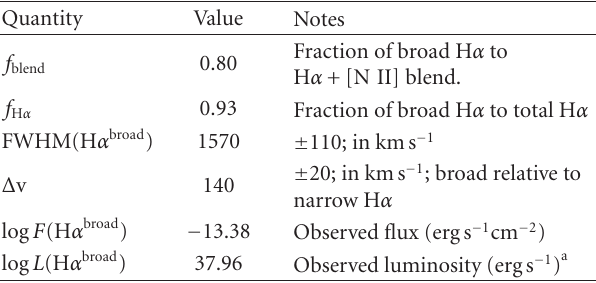
Figure 1: Spectral fits to the HST -STIS spectrum of NGC 4736, based on a 5-pixel extraction aperture, which corresponds to a total emission area of 0.025 arcsec 2 . Upper panel : The thin continuous line shows the observed data, while the green line shows the best- fit stellar population model obtained by clipping out the hashed emission-line region. Middle panel : The continuum subtracted spectrum, that is, the emission-line component, together with the corresponding spectral fit, that have been shifted by an additive constant to match the initial continuum level, for illustration purposes. The thin continuous lines show the individual Gaussian components (1 per narrow line), the thick grey continuous line represents the broad H α feature, and the red line is the final fit to the observed spectrum. Lower panel : The residuals after the subtraction of the model fit. Table 1: Broad H α emission